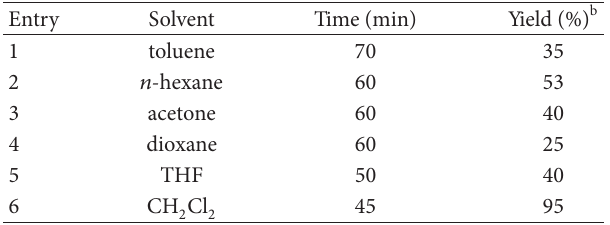
T 1: e effect of solvent for tetrahydropyranylation of benzyl alcohol a